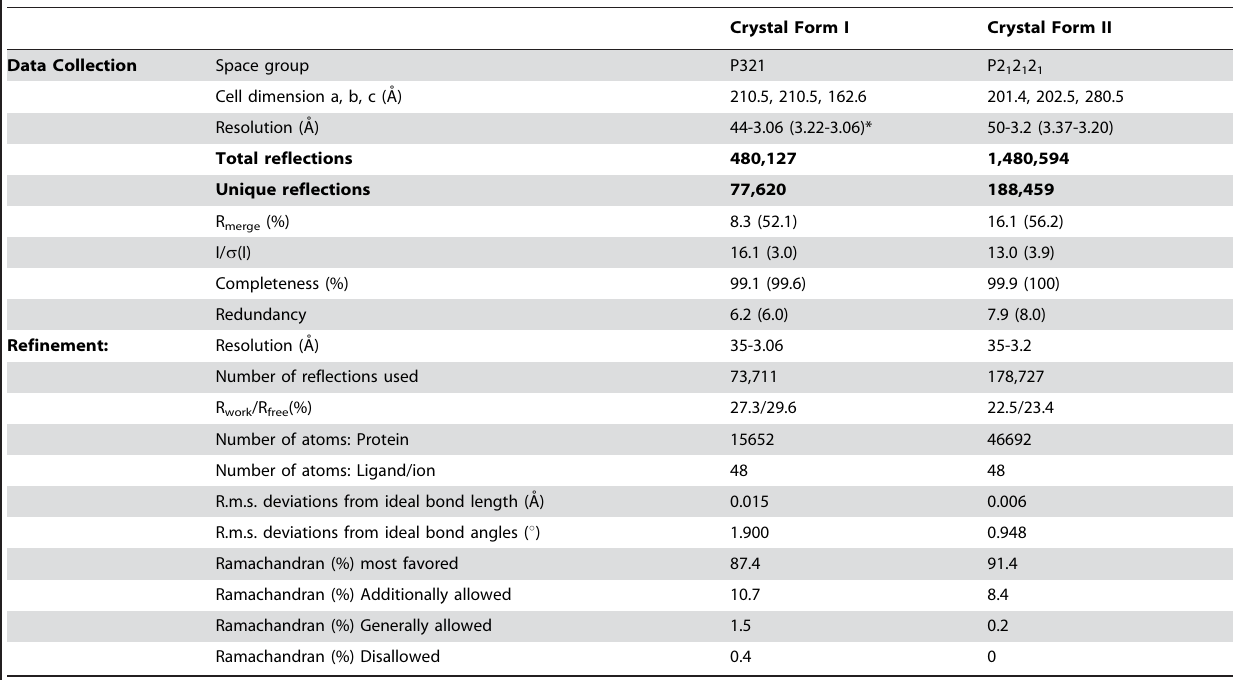
Table 1. Data collection and refinement statistics.